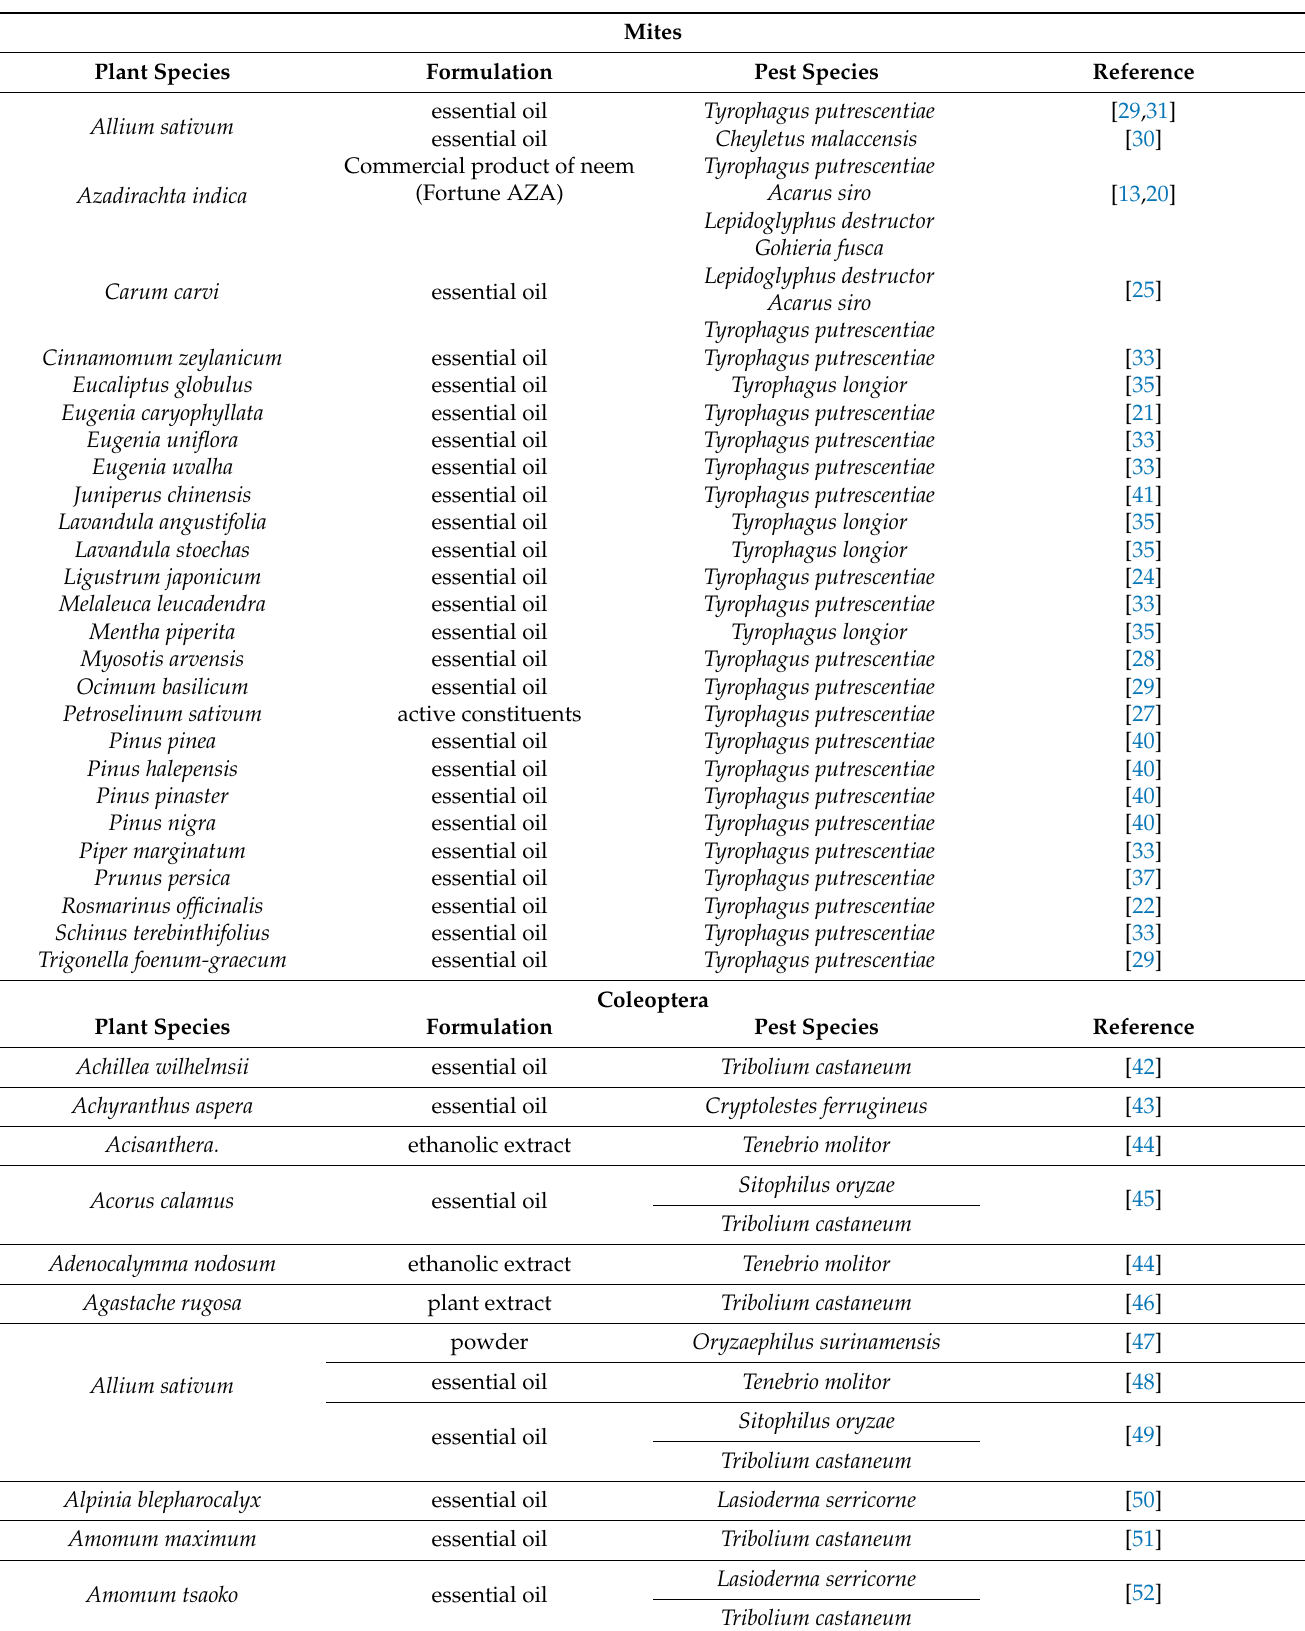
Table 1. Plant species reported to exhibit significant activity against stored-product pests in recent